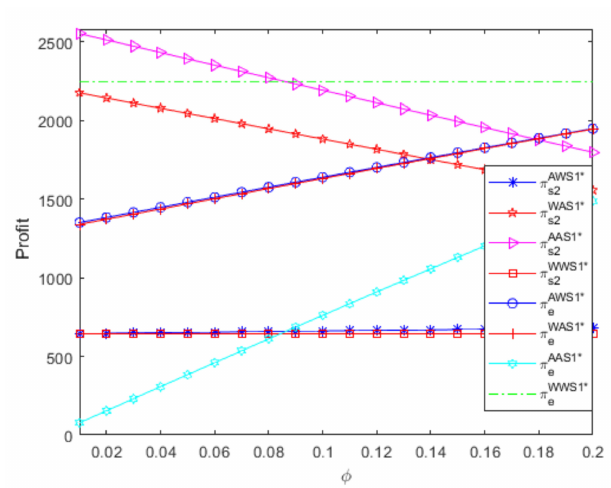
Figure 2. Changes of two suppliers’ profits with φ .